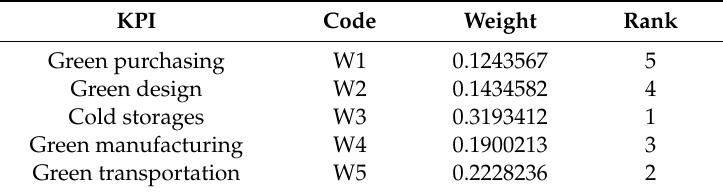
Table 15. Weight and ranking of KPIs in executive indicators category (taken from fuzzy nonlinear model).